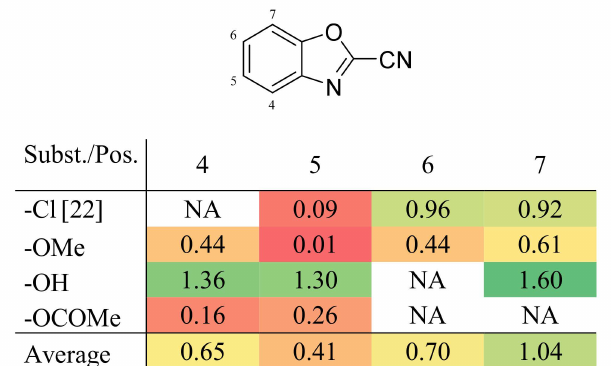
Figure 2. Group efficiency analysis of benzoxazoles. GE values are color-coded row-wise (green to red for large to small) according to the relative contribution to the binding free energy. GE was calculated as ∆ pIC 50 / ∆ N heavy with compound 1 as a reference. IC 50 = 80 µ M and 5 µ M was used for 5-OMe (RA = 84% at 10 µ M) and 7-OMe (RA = 20% at 10 µ M),